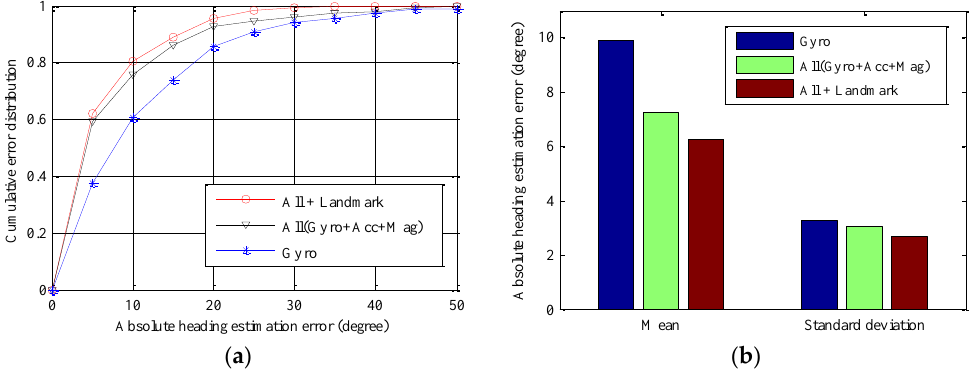
Figure 6. Performance comparisons of absolute heading estimation error of path two: ( a ) cumulative error distribution; and ( b ) mean and standard deviation.